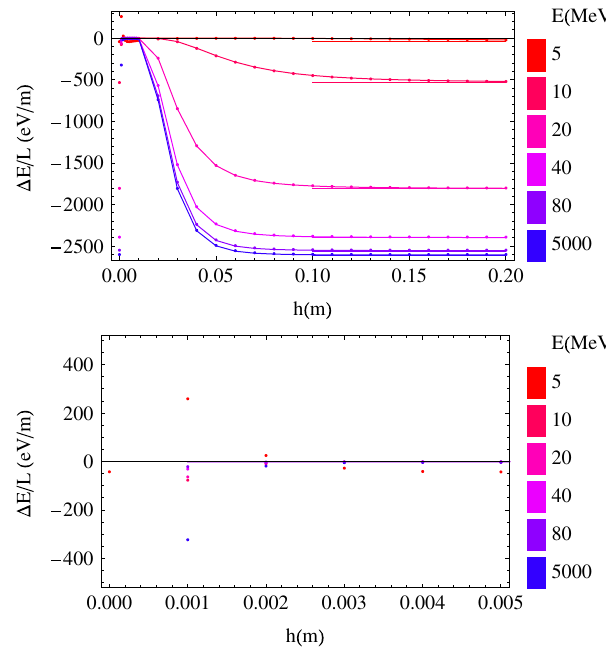
FIG. 18. (Color) Average energy losses versus shielding height for various energies. The bottom plot is the same as the top highlighting the smaller heights. Bmad (dots) agrees well with numerical integration of Eq. (59) (curved lines) using the shielded power spectrum of [1] down to 2 mm. Steady-state losses computed using Eq. (60) are indicated as horizontal lines.